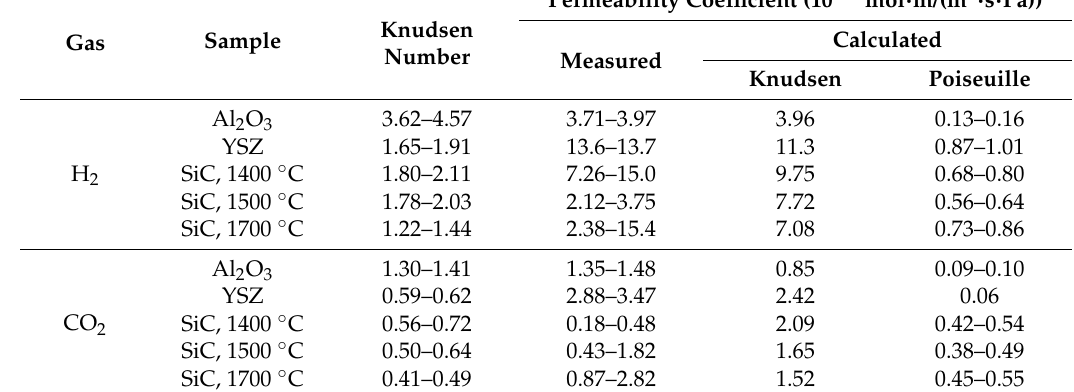
Table 1. Summary of permeability coefficients in Figure 9.